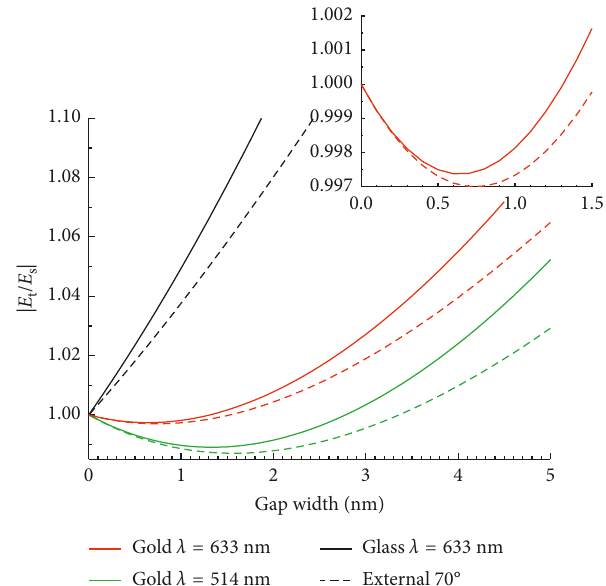
Figure 1: The ratio of fields at the tip apex and at the contacting surface for different substrate materials and wavelengths versus the tip-surface separation. Solid lines represent results for the tip source [1], and dashed lines represent results for the external